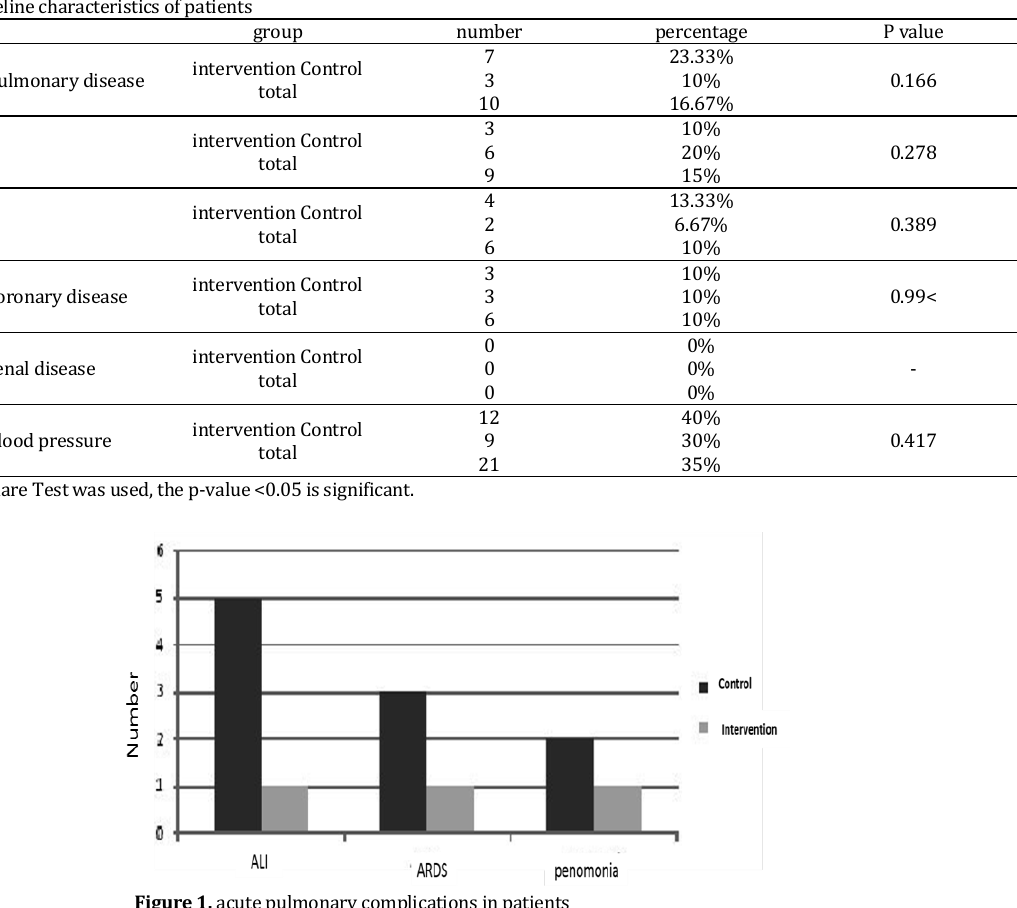
Table 1. Baseline characteristics of patients